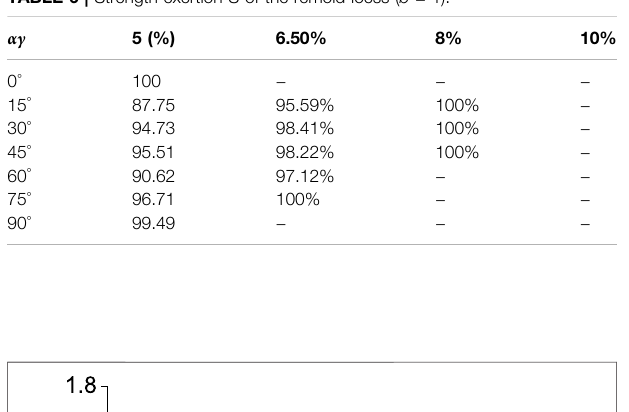
TABLE 6 | Strength exertion S of the remold loess ( b = 1).